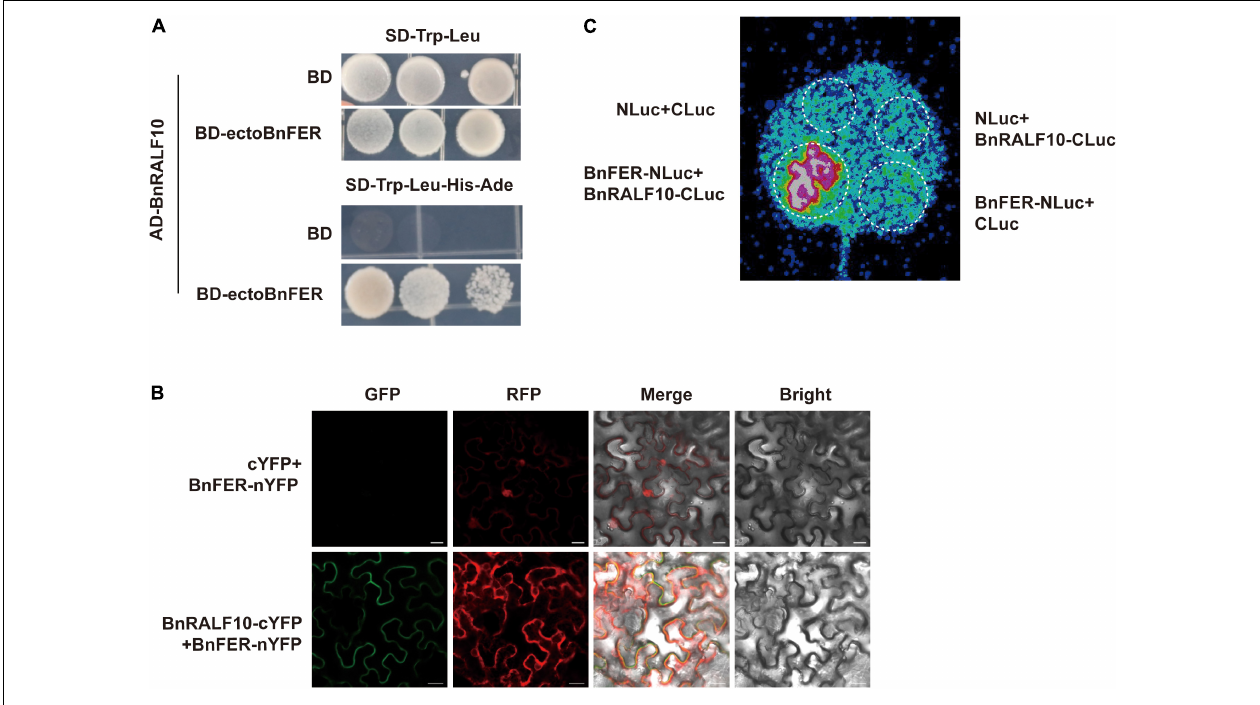
FIGURE 7 | BnRALF10 physically interacted with BnFER. (A) BnRALF10 interacts with the extracellular domain of BnFER in yeast. Yeast (strain AH109) co-transformed with pGBKT7 (BD) or the BD-ectoBnFER bait vector and pGADT7 (AD)-BnRALF10 prey vector was grown on SD–Trp–Leu, SD–Trp–Leu–His–Ade plates for interaction confirmation. Only yeast co-transformed with BD-ectoBnFER and AD-BnRALF10 grew on the SD–Trp–Leu–His–Ade medium. BD + AD-BnRALF10 was used as negative control. (B) BiFC assay to detect BnRALF10–BnFER interaction in N. benthamiana . YFP fluorescence was detected in N. benthamiana leaves co-expressing BnRALF10-cYFP and BnFER-nYFP (Lower) but not in the control (cYFP + BnFER-nYFP; Upper). Scale bar: 20 µ m. (C) LCI assay to monitor BnRALF10–BnFER interaction in N. benthamiana . LUC activity was detected in N. benthamiana leaves co-expressing BnRALF10-CLuc and BnFER-NLuc but not in the controls (BnRALF10-CLuc + NLuc, CLuc + BnFER-NLuc and CLuc +